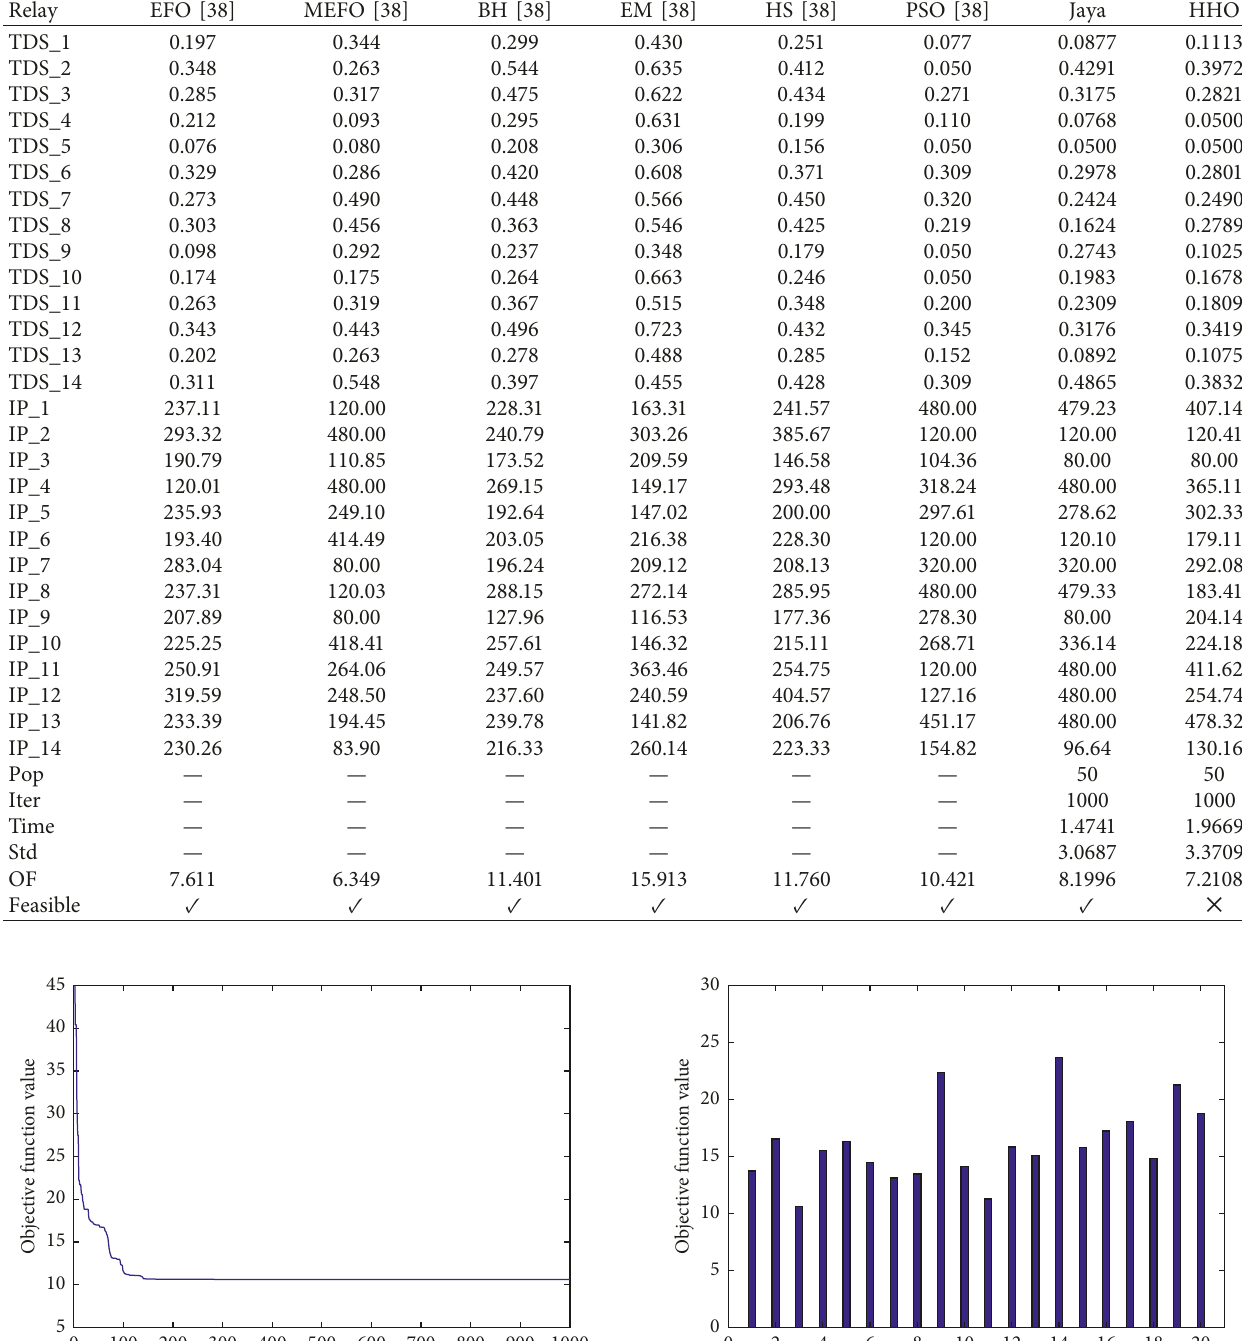
Table 9: Time dial setting and pickup current for the 8-bus system by NLP formulation.